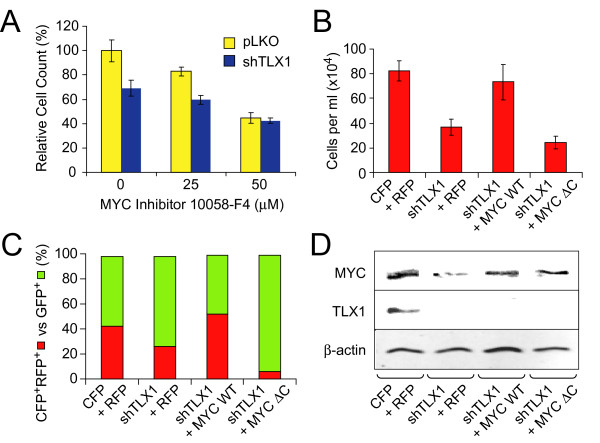
Role of MYC as a downstream component of the TLX1/NOTCH regulatory network. (A) Chemical inhibition of MYC (10058-F4 treatment) mimics TLX1 knockdown in ALL-SIL cells expressing shRNA93 versus pLKO.1-CFP expressing TLX1+ controls. (B) Expression of wild-type but not an inactive MYC mutant (MYC ΔC) compensates for the lack of TLX1 expression in ALL-SIL cells treated with GSI. TLX1 shRNA93 was co-expressed with CFP; MYC constructs were coexpressed with RFP. ALL-SIL cells expressing pLKO.1-CFP-TLX1 shRNA93 were transduced with retroviral vectors coexpressing RFP alone, wild-type MYC plus RFP or the MYC ΔC mutant plus RFP and sorted for CFP and RFP expression. Equal numbers were seeded and counted after 2 weeks in culture. CFP + RFP, parental ALL-SIL cells coexpressing CFP and RFP. (C) Growth competition experiments. The same CFP+RFP+ ALL-SIL derivatives as in B were mixed with parental ALL-SIL cells expressing GFP in equal proportions. Aliquots were periodically analyzed by flow cytometry; shown are data 2 weeks after initiation of the experiment. (D) Western blot analysis showing MYC protein levels and the corresponding levels of TLX1 for the cell lines studied in B and C.